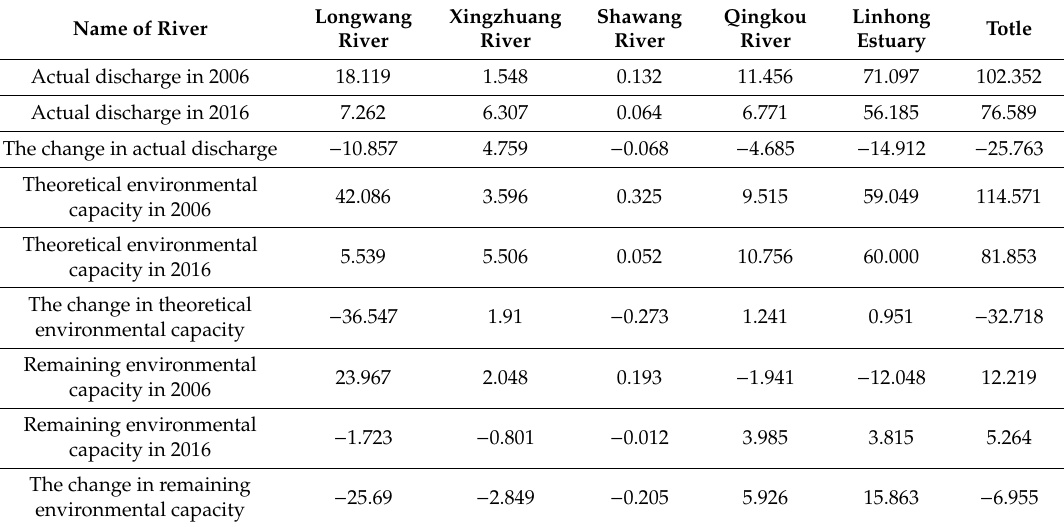
Table 7. The actual changes in the COD environmental capacity of the coastal estuaries of Haizhou Bay between 2016 and 2006 (Unit: